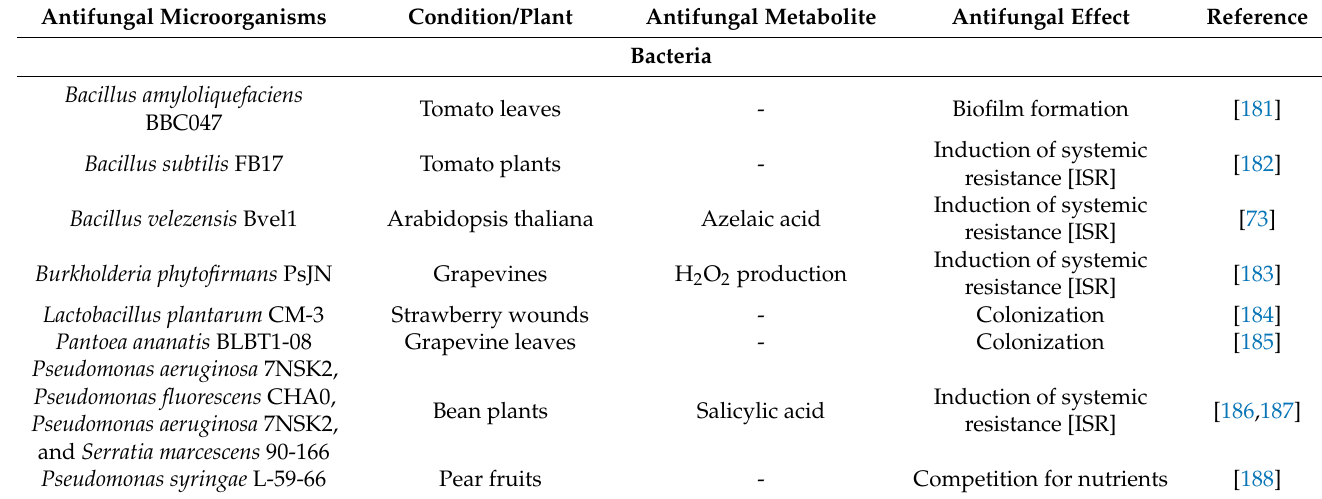
Table 4. Overview of literature reporting the inhibition of Botrytis cinerea by other mechanisms. Antifungal